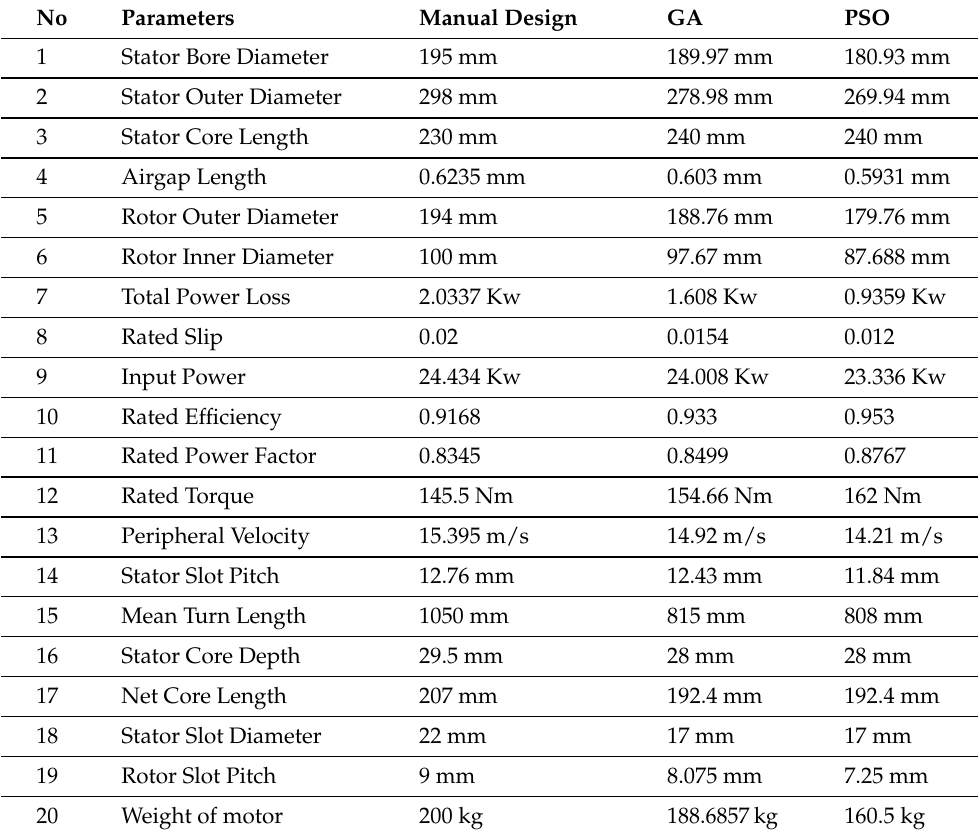
Table 6. Comparison of Design Optimization